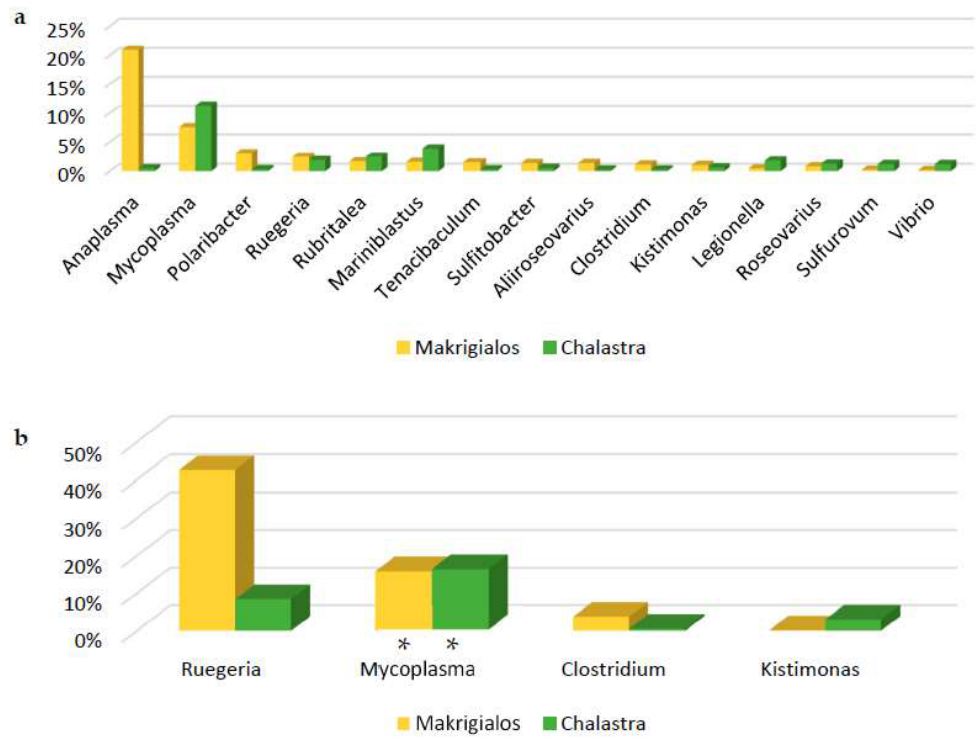
Figure 4. Comparison of the most abundant bacterial genera between ( a ) Chalastra-Makrigialos in winter and ( b ) Chalastra-Makrigialos in summer. Statistically non-significant pairwise comparisons are marked with an asterisk.